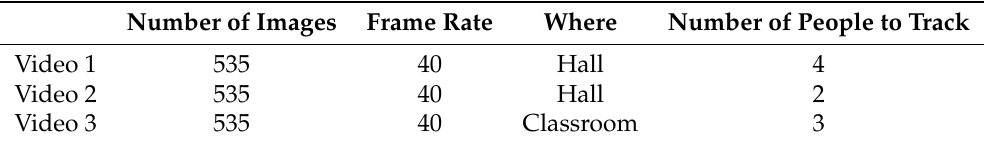
Table 4. Main characteristics of the applied